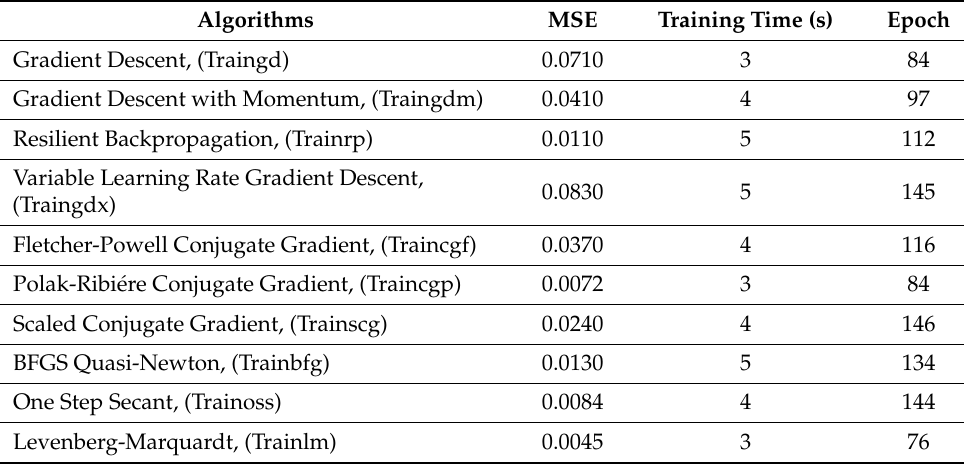
Table 6. Influence of BP